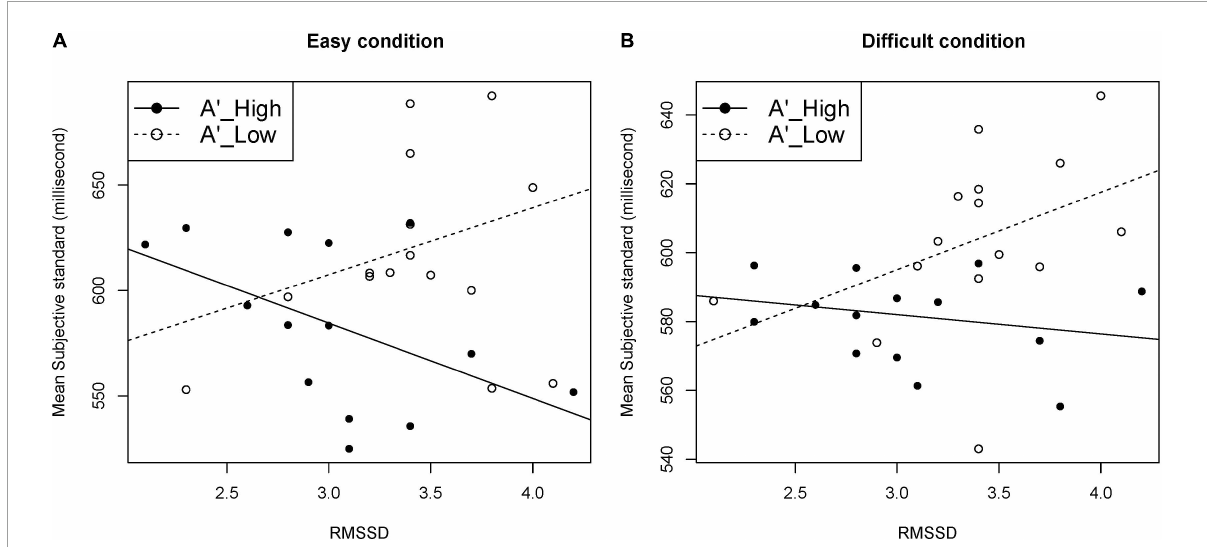
FIGURE5 Moderation effect of A’ on the relationship between RMSSD and MSS. Data were split by median of A’ into higher- A’ group ( n = 14) and lower- A’ group ( n = 15). (A) Easy condition, (B) difficult condition. A’ , sensitivity independent of the response criterion according to the signal detection theory; RMSSD, root mean square of successive differences of RR intervals; MSS, mean of the subjective